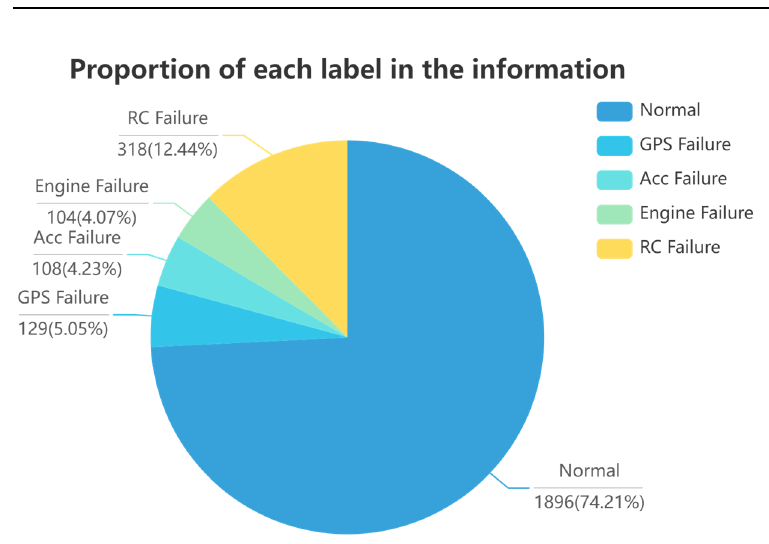
Figure 17. Percentage of labels before data processing.